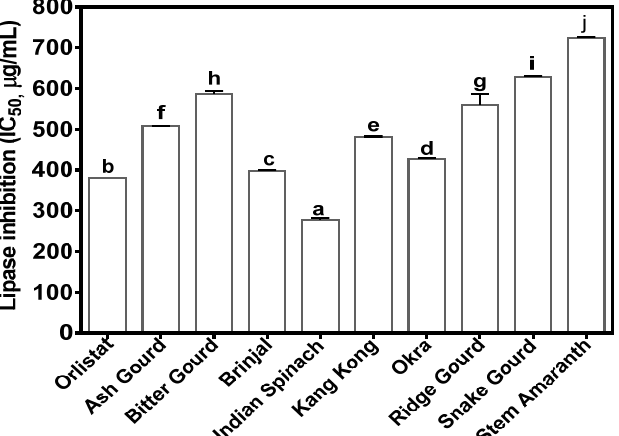
Figure 3. IC 50 values ( n = 3 ± standard deviation) for the inhibition of pancreatic lipase (PL) activity by orlistat and aqueous polyphenolic extracts of vegetables. Bars with di ff erent letters have mean values that are significantly ( p < 0.05) di ff erent. Figure 3: IC 50 values for the inhibition of pancreatic lipase activity by orlistat and aqueous polyphenolic extracts of vegetables. Bars are means (n=3) ± standard deviations.